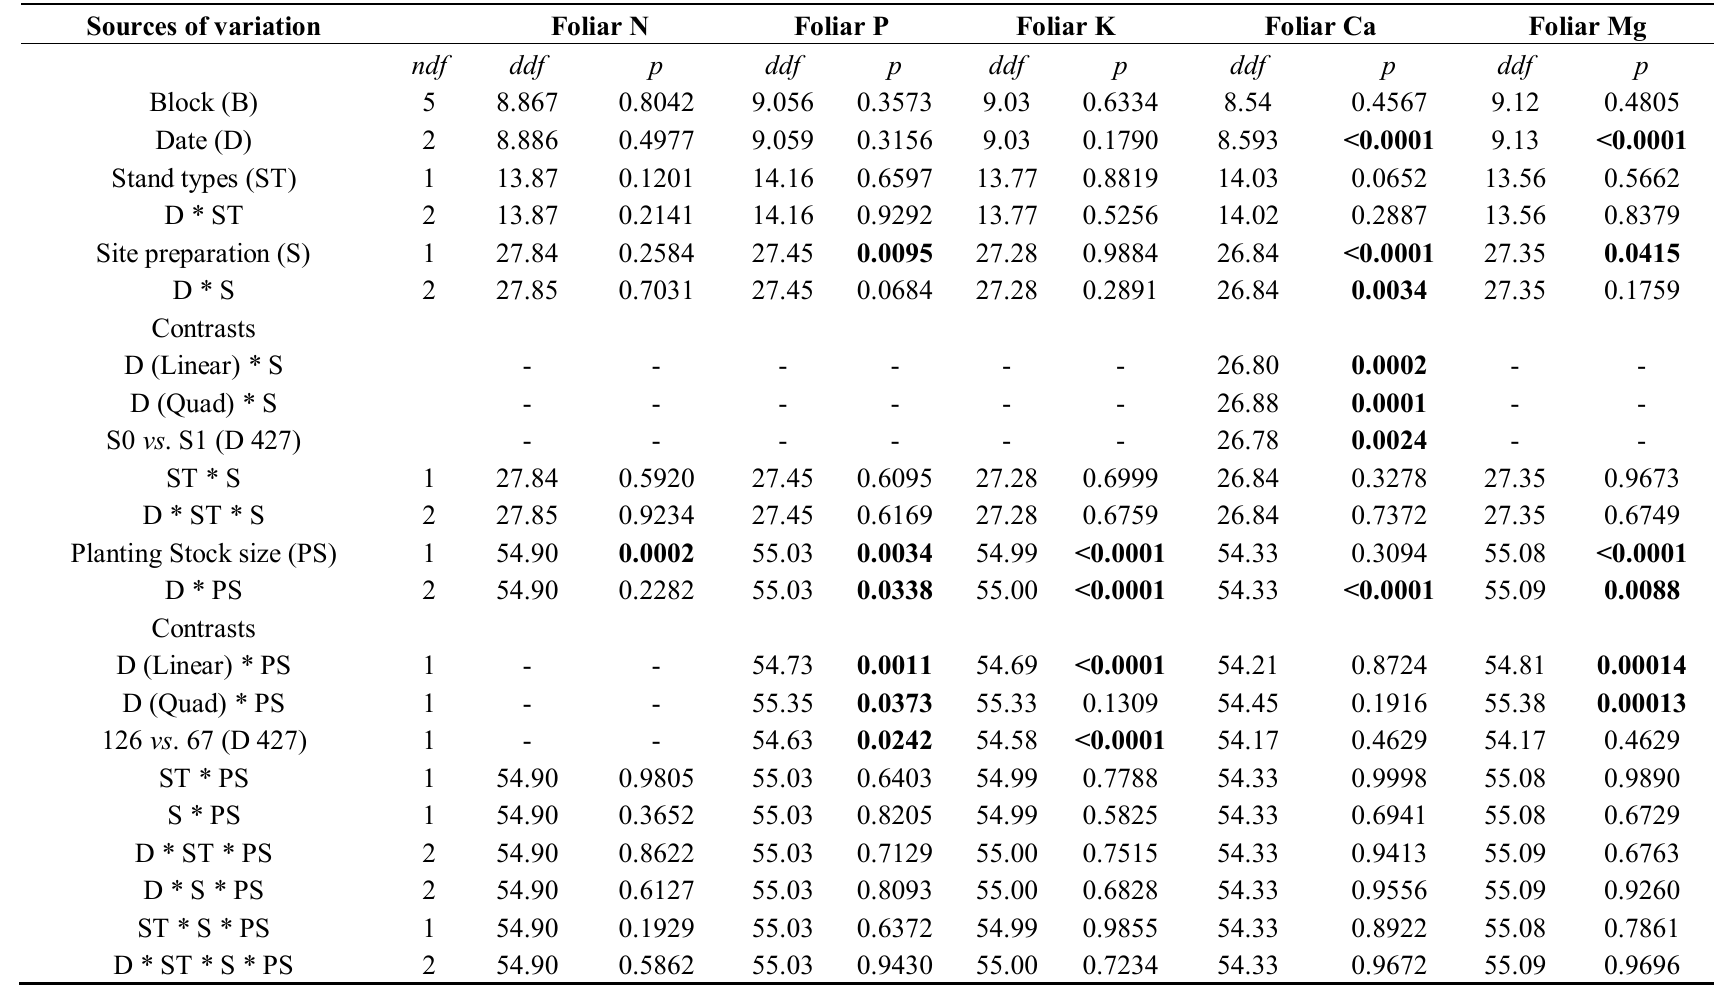
Table 2. Summary of ANOVA results for the nutrient concentration (N, P, K, Ca, Mg) in current year foliage of black spruce seedlings one year after plantation in lichen woodlands and black spruce feather-moss stands, in scarified or unscarified plots and with smaller (126-25) or larger (67-50) containerized stock